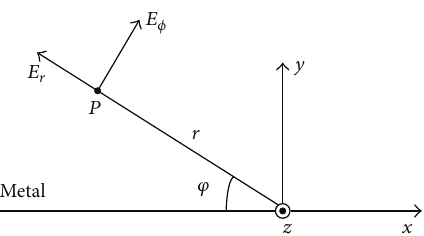
Figure1:Transverseelectricandmagneticfieldcomponentsaround a microstrip line